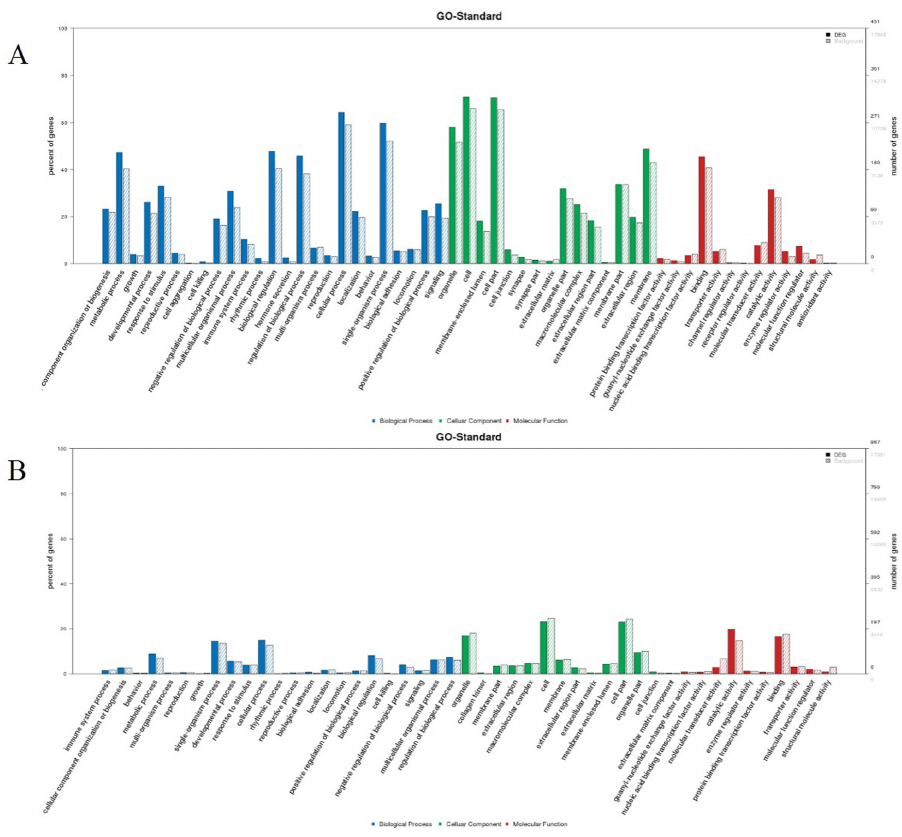
Figure 5. Gene ontology (GO) functional classification of all differentially expressed genes (DEG) predicated from the known miRNA. ( A ) The GO distribution of the DEG in the PPR vaccine virus ‐ inoculated sheep PBMC at 3 dpi versus mock ‐ inoculated; ( B ) The GO distribution of the DEG in the PPR vaccine virus ‐ inoculated ST cells versus mock ‐ inoculated.